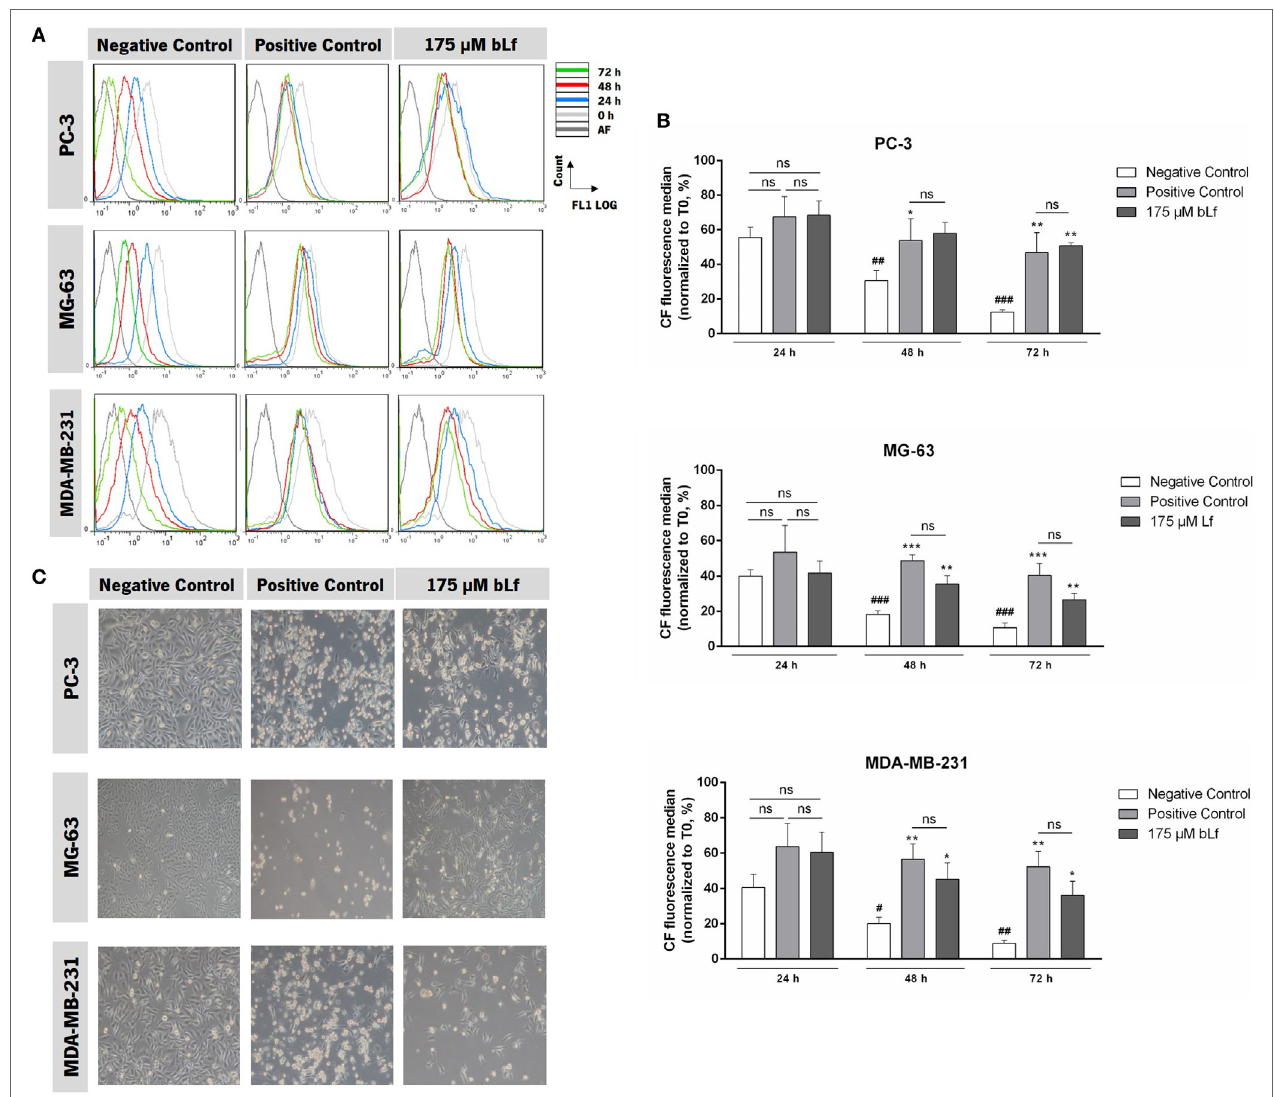
FigUre 1 | Bovine lactoferrin (bLf) inhibits proliferation of highly metastatic cancer cell lines. (a) Representative histograms of cell proliferation analysis with carboxyfluorescein diacetate succinimidyl ester probe of the different conditions after 0, 24, 48, and 72 h exposure to bLf in the three indicated cell lines. Unexposed cells were used as a negative control and 50 µM cisplatin (for MG-63 and MDA-MB-231 cell lines) or 60 µM etoposide (for PC-3 cells) were used as positive controls. (B) Quantification of the carboxyfluorescein median fluorescence intensity values normalized to T0 after 24, 48, and 72 h of exposure. Values represent median ± SD of three independent experiments. * P < 0.05, ** P < 0.01, and *** P < 0,001 compared with negative control of each time point and # P < 0.05; ## P < 0.01, and ### P < 0,001 compared with 24 h. (c) Representative images of cell cultures after 48 h of treatment with bLf, cisplatin or etoposide in PC-3, MG-63, and MDA-MB-231 cell lines (10 × phase